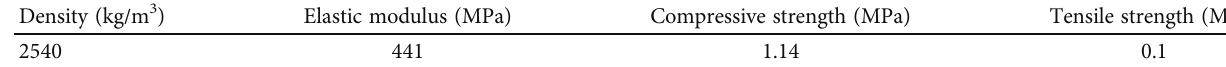
Table 2: Mechanical parameters of similar materials.